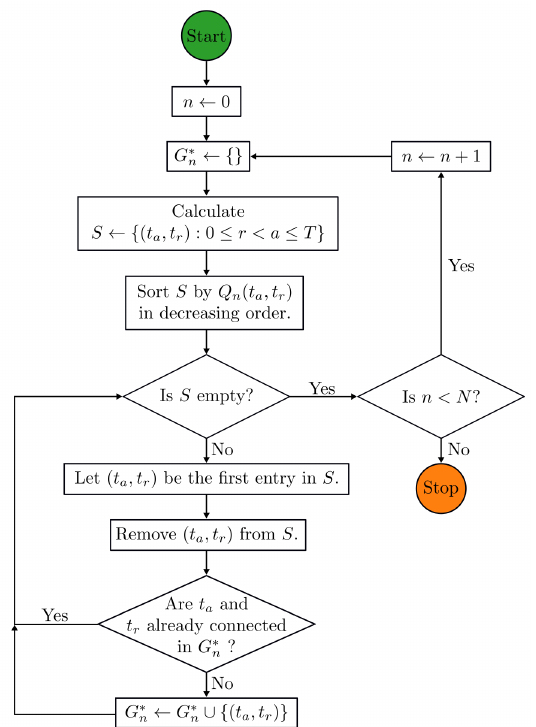
Figure 3. Flow diagram for Kruskal’s algorithm, where G ∗ n indicates a maximum spanning tree of G n